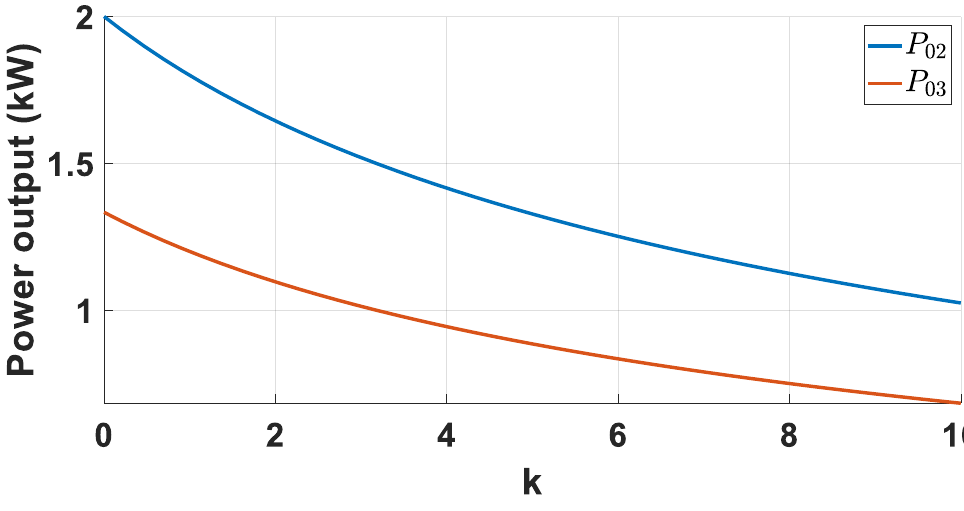
Figure 7. Sensitivity of 𝑃 02 and 𝑃 03 to k.